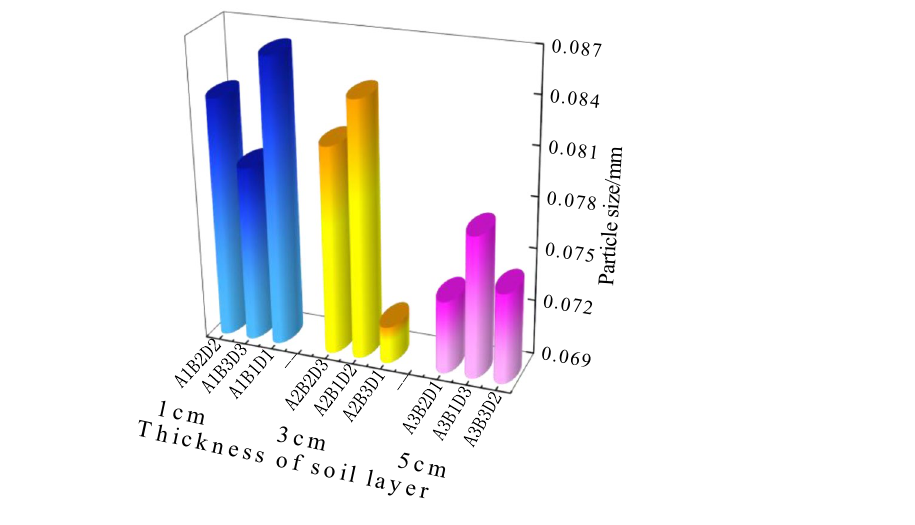
Figure 20. Graph of particle size versus soil thickness.